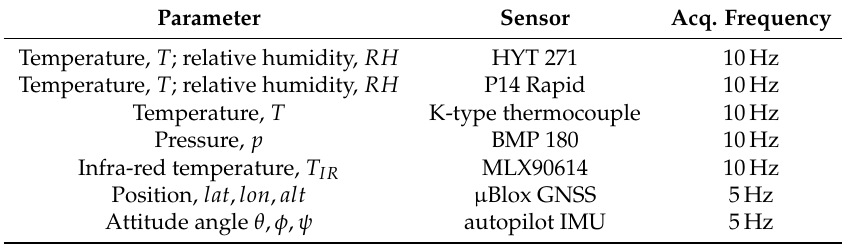
Table 5. Specifications of the sensors mounted on the Advanced Mission and Operation Research (AMOR) UAV.